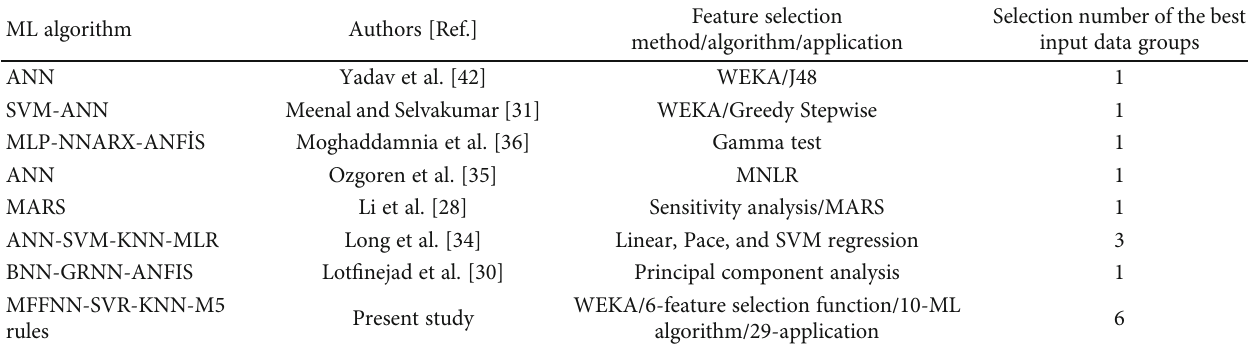
Table 3: Comparison of feature selection methods and techniques used in previous studies and those used in the present study.